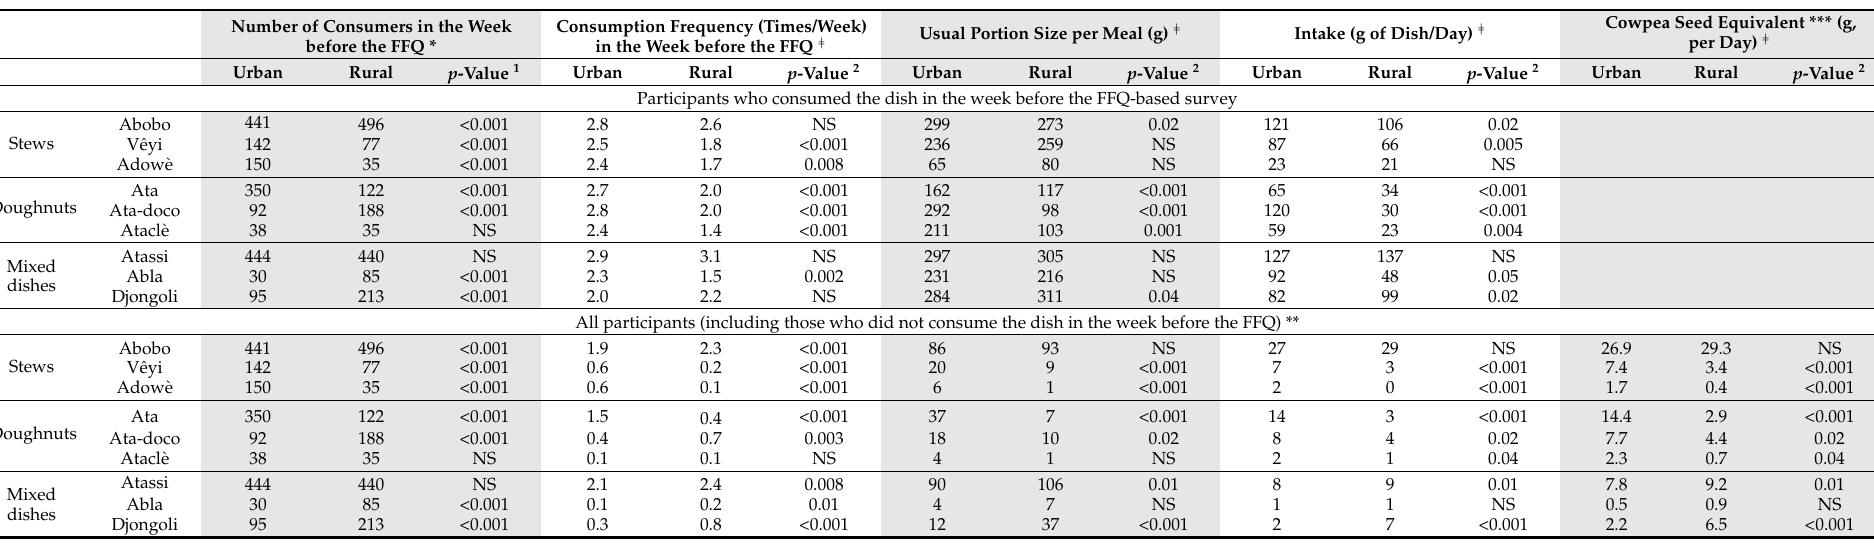
Table 3. Quantities of cowpea-based dishes consumed (g, fresh weight) and cowpea seed equivalent (g, fresh weight) in the urban and rural study